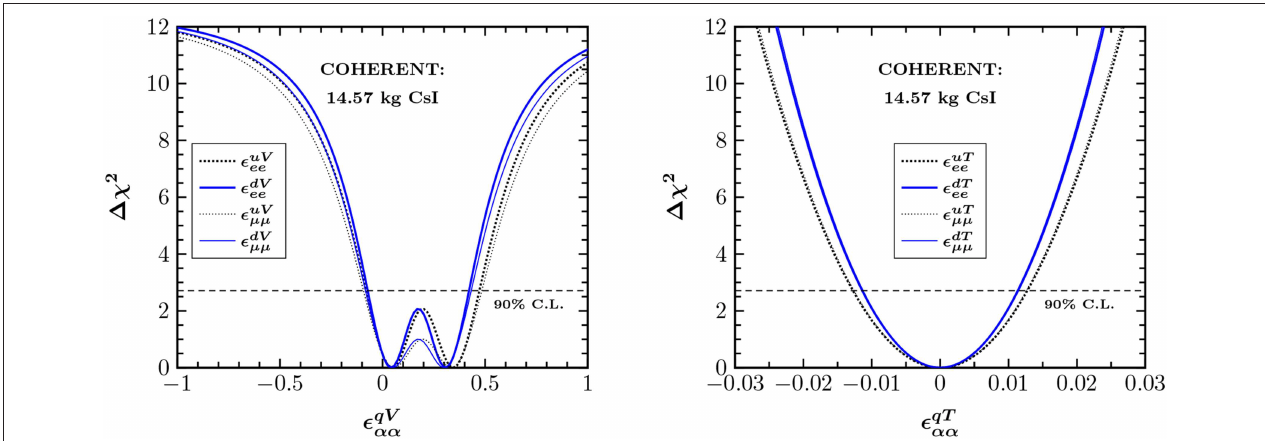
ν µ ) beam. Figure adapted + ¯